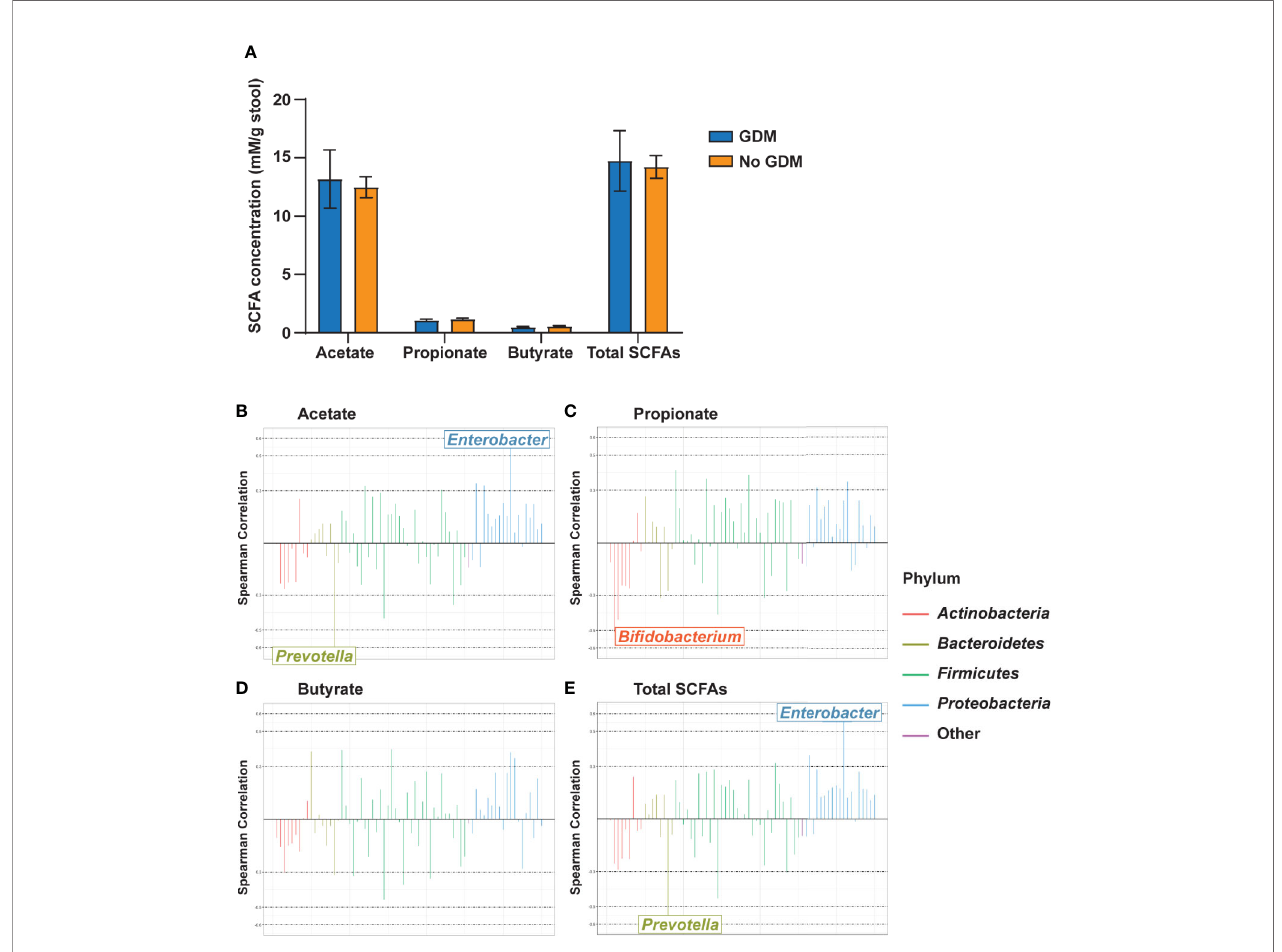
FIGURE 5 | Gut microbiota genus-level taxa correlate with infant stool SCFA levels. (A) Infant stool SCFA levels by maternal GDM status. Rocky Mountain Plots representing (B) acetate, (C) propionate, (D) butyrate, and (E) total SCFA measurements with a center log ratio transformation of genus-level counts. Correlations were derived using Spearman Correlation with r > |0.5| indicating a meaningful correlation. n = 23 for each